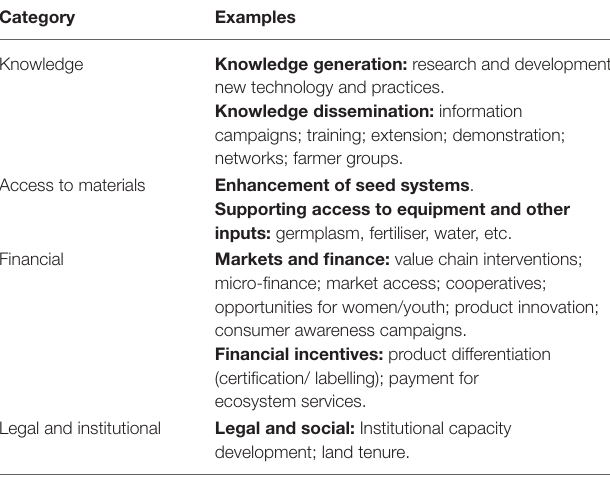
TABLE 1 | Categories of levers and policy interventions to encourage changes in land use and management.